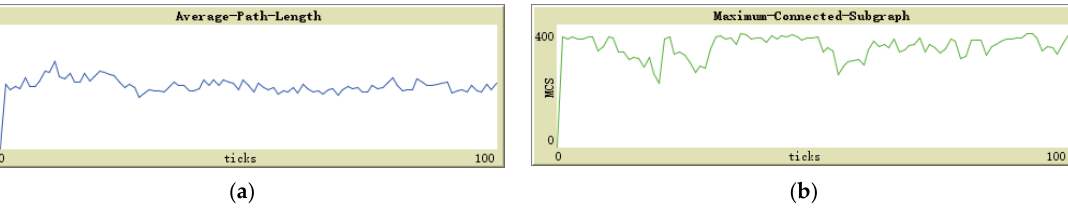
Figure 8. ( a ) APL trend with global maintenance; ( b ) MCS trend with global maintenance.